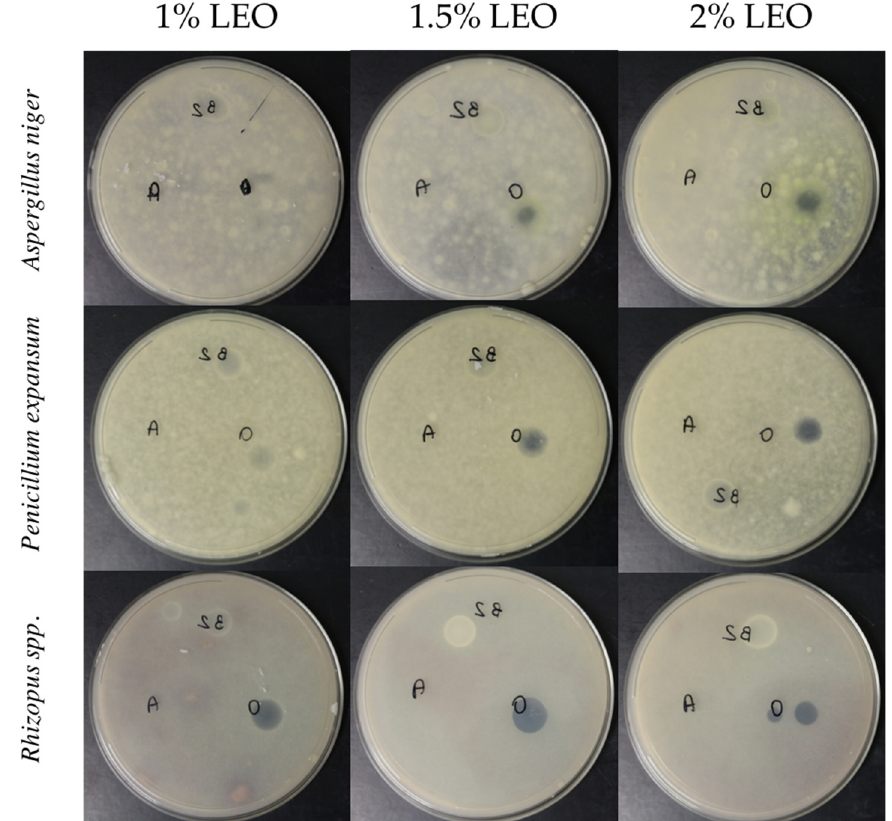
Figure 4. Mycelial growth inhibition of nanoformulations at different concentrations of lemon grass essential oil against Aspergillus niger, Penicillium expansum and Rhizopus spp. after 9 days of incubation at 25 °C. B2 = control spot containing alginate/Tween 80; A = essential oil in water, O = essential oil nanoformulation.